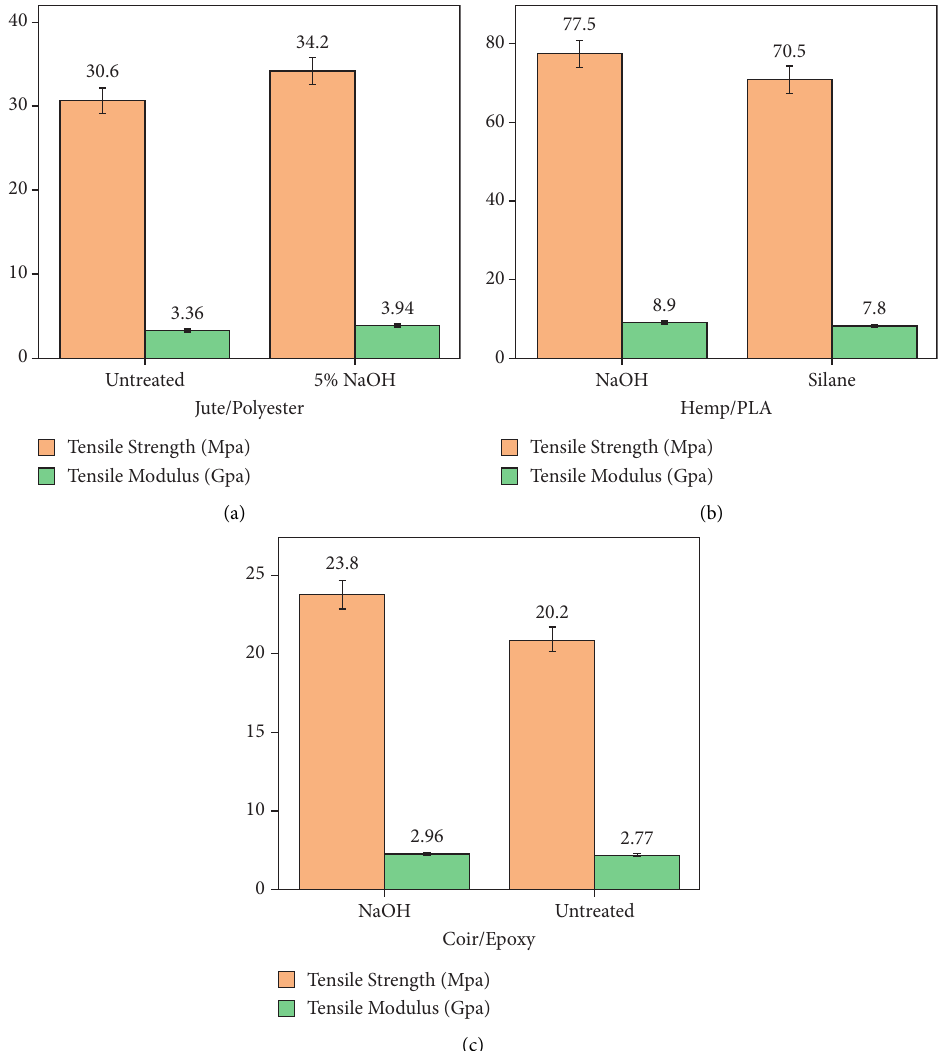
Figure 5: Tensile properties of 5% NaOH-treated jute/polyester and hemp/PLA composites